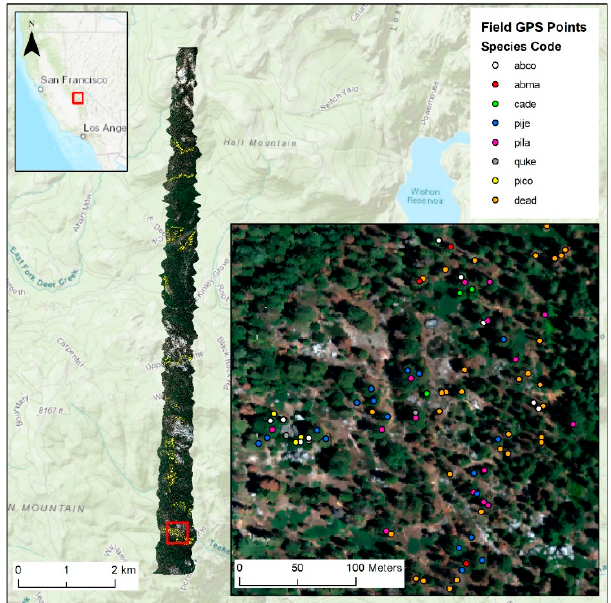
Figure 1. National Ecological Observation Network (NEON) Airborne Observation Platform Red-Green-Blue hyperspectral subset orthophoto imagery showing the location of the strip of hyperspectral imagery used in analysis (left) intersecting the Teakettle Experimental Forest (TEF) Watershed north-east of Fresno, CA (upper left inset). Zoomed view at the southern end of the flight transect (area in red square) and an example of individual tree points collected in the field using high precision Global Positioning System (GPS), colored based on the species (seven species) or mortality status (lower right). Field GPS Point training data collected by the authors and by University of New Mexico field teams in the TEF permanent plots are shown as yellow and are located within transects crossing the flightline (left).